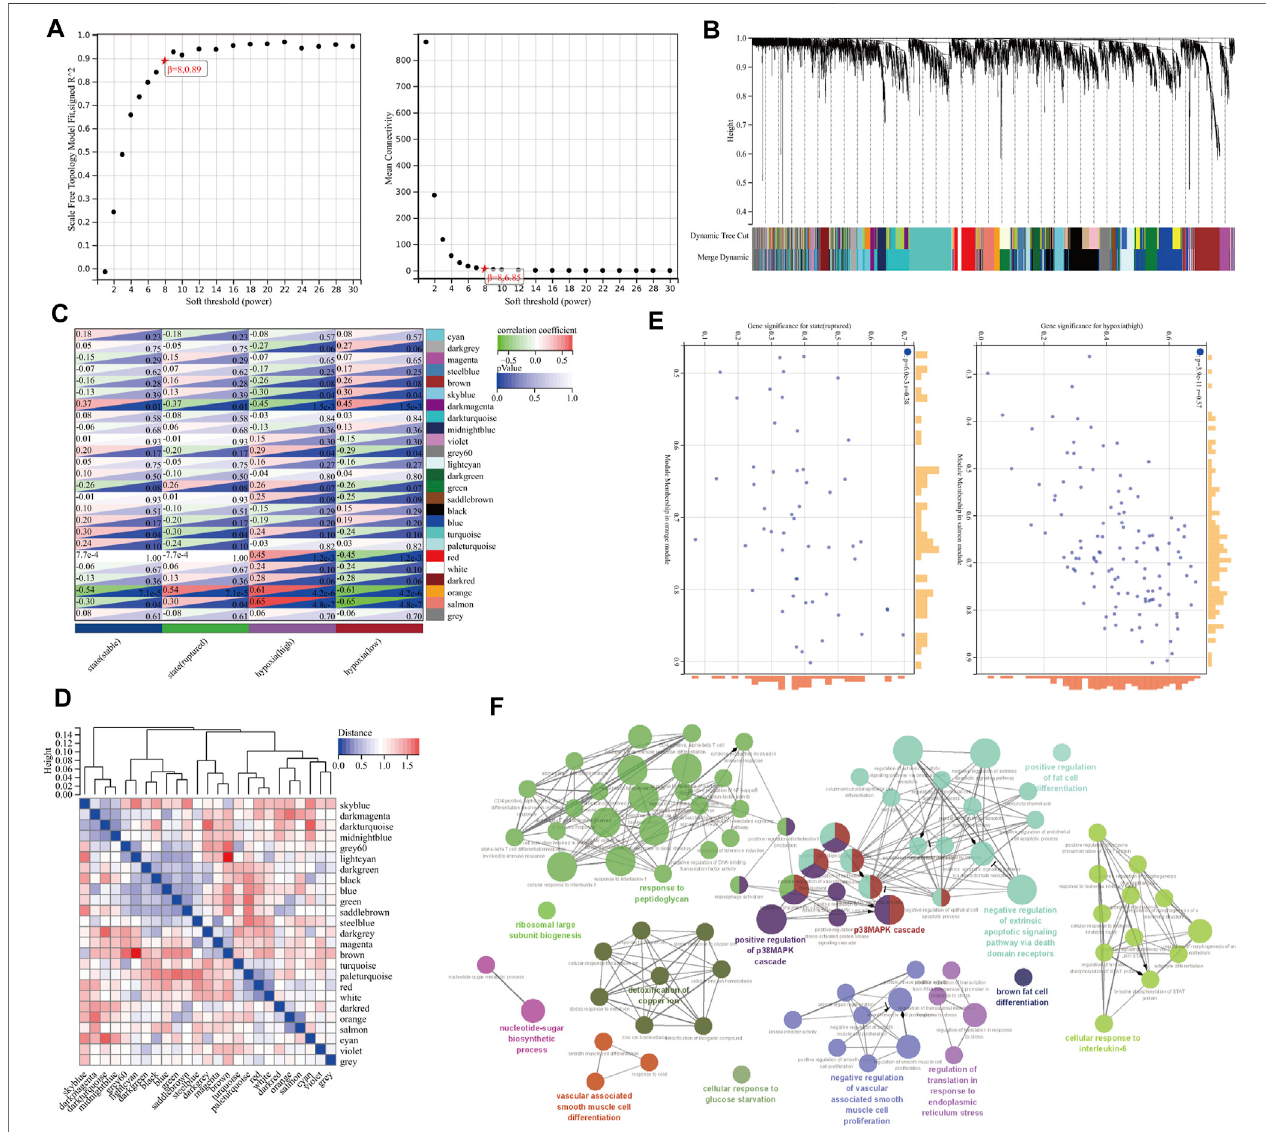
FIGURE 3 | Construction of the gene coexpression network by WGCNA. (A) Soft-threshold power for WGCNA. The soft-thresholding power was selected from 1 – 20,thecoef fi cientthresholdwassetto0.89,andthesoftthresholdwassetto8. (B) Dendrogramofthegeneclusteranalysisofall fi lteredgenesets.The fi rstrowatthe bottom of the dendrogram indicates the unmerged dynamic tree cut, and the second row shows the 25 merged modules, with different colors indicating different modules. (C) Hierarchical clustering and correlation heatmap of all module genes. The bluer the color is, the higher the correlation. (D) Heatmap of the correlation between different module genes and hypoxia and AAA status. Darker colors indicate higher correlations and smaller p value s with greater statistical signi fi cance. (E) A scatterplot of GS and MM scores of genes in the orange and salmon modules. (F) GO enrichment analysis of genes in the orange and salmon modules.